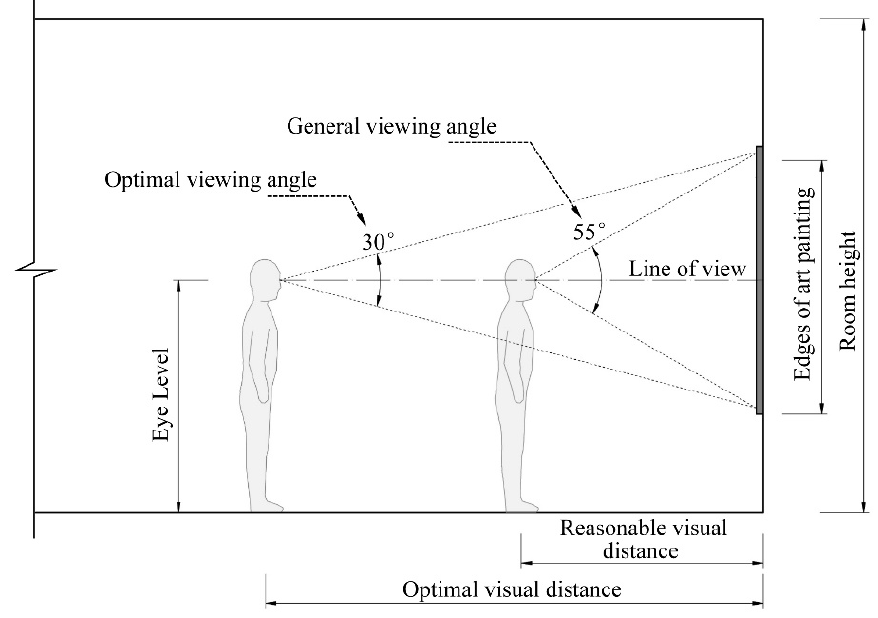
Figure 12. The relationship between painting and observers’ visual distance.